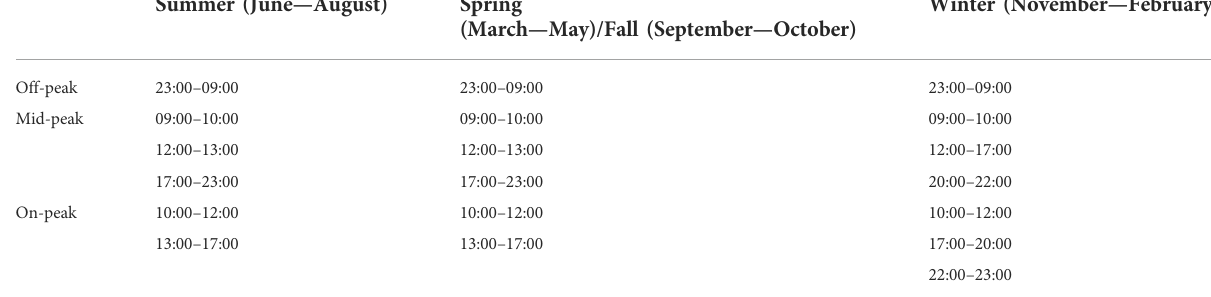
TABLE 3 Electricity rate